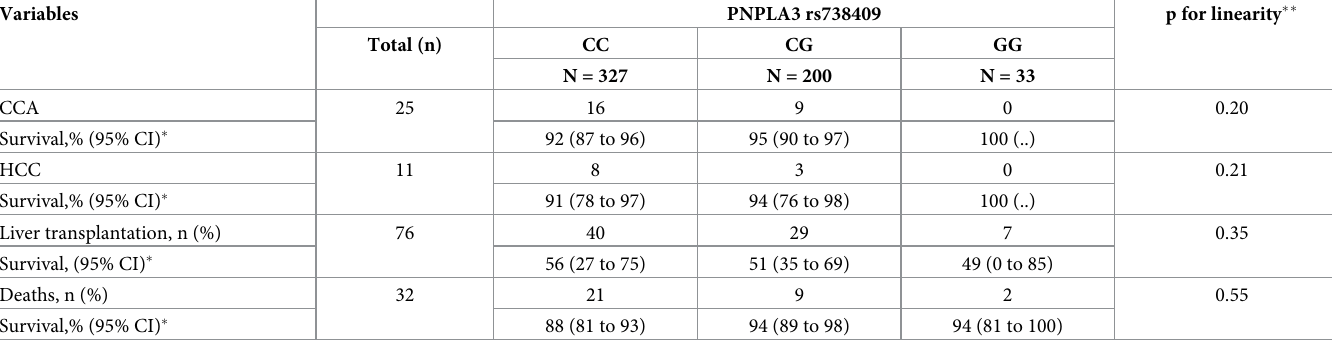
Table 2. Effect of PNPLA3 allele frequency on study population’s crude 25-year survival rate and significant outcomes. Variables